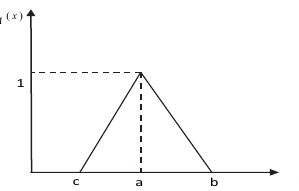
Fig. 2. Membership function of a triangular fuzzy